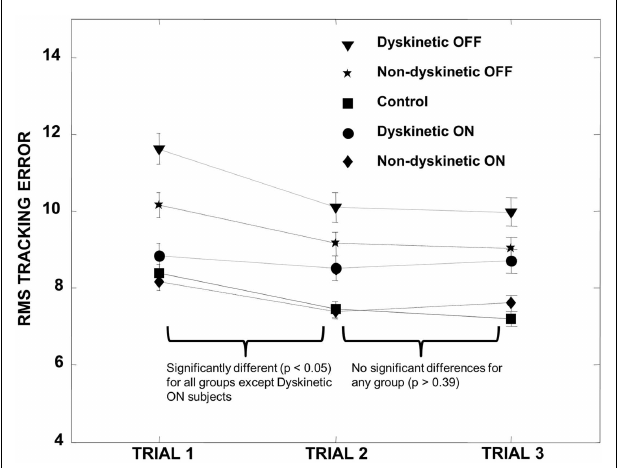
FIGURE 1 |Training effect . All groups demonstrated a significant decrease in RMS error between trial 1 and trial 2 except for the DPD ON group (where the decrease was not significant), and the RMS error subsequently stabilized for all groups between trials 2 and 3.We therefore omitted trial 1 data in all subsequent calculations. Error bars represent the standard error.